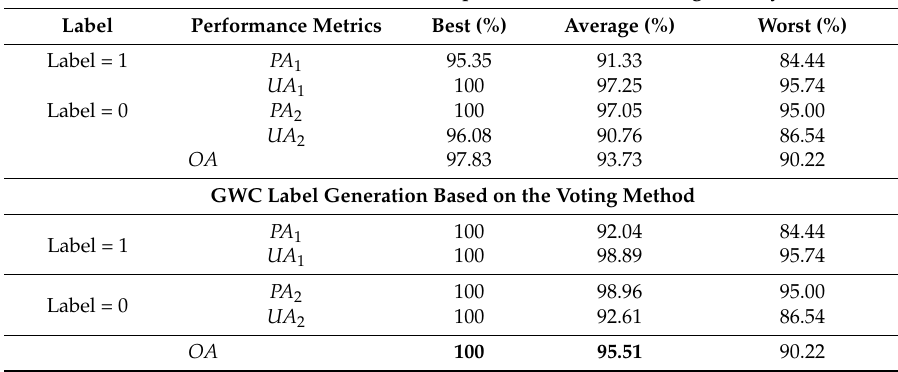
Table 1. The classification evaluation results of the proposed DPVSD model in different cases: a comparison between two GWC label generation methods.